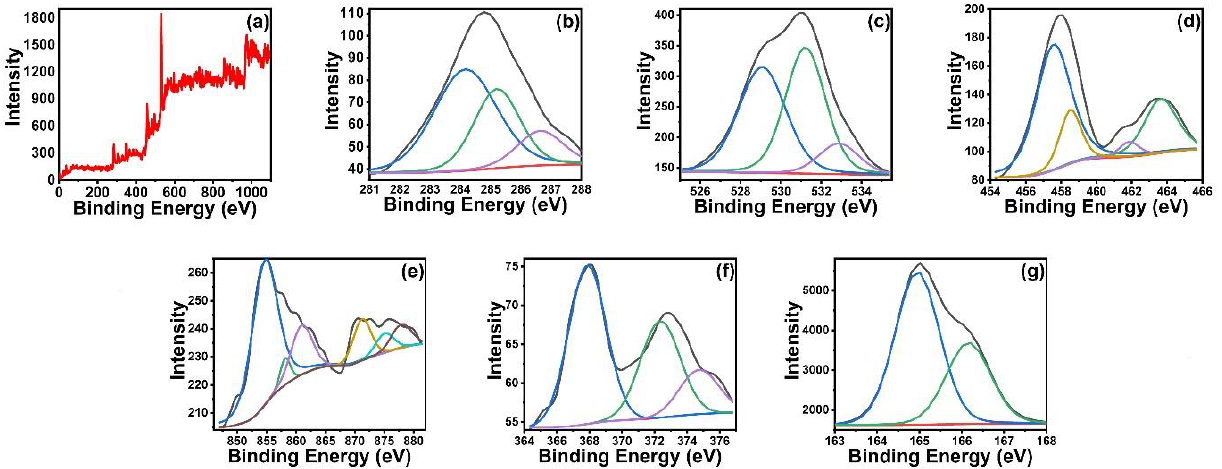
Figure 7. XPS spectra of Ni 3 S 4 /Ag 2 S/TiO 2 /CA. Survey scan ( a ), C1s ( b ), O1s ( c ), Ti2p ( d ), Ni2p ( e ), Ag3d ( f ) and S2p ( g ).